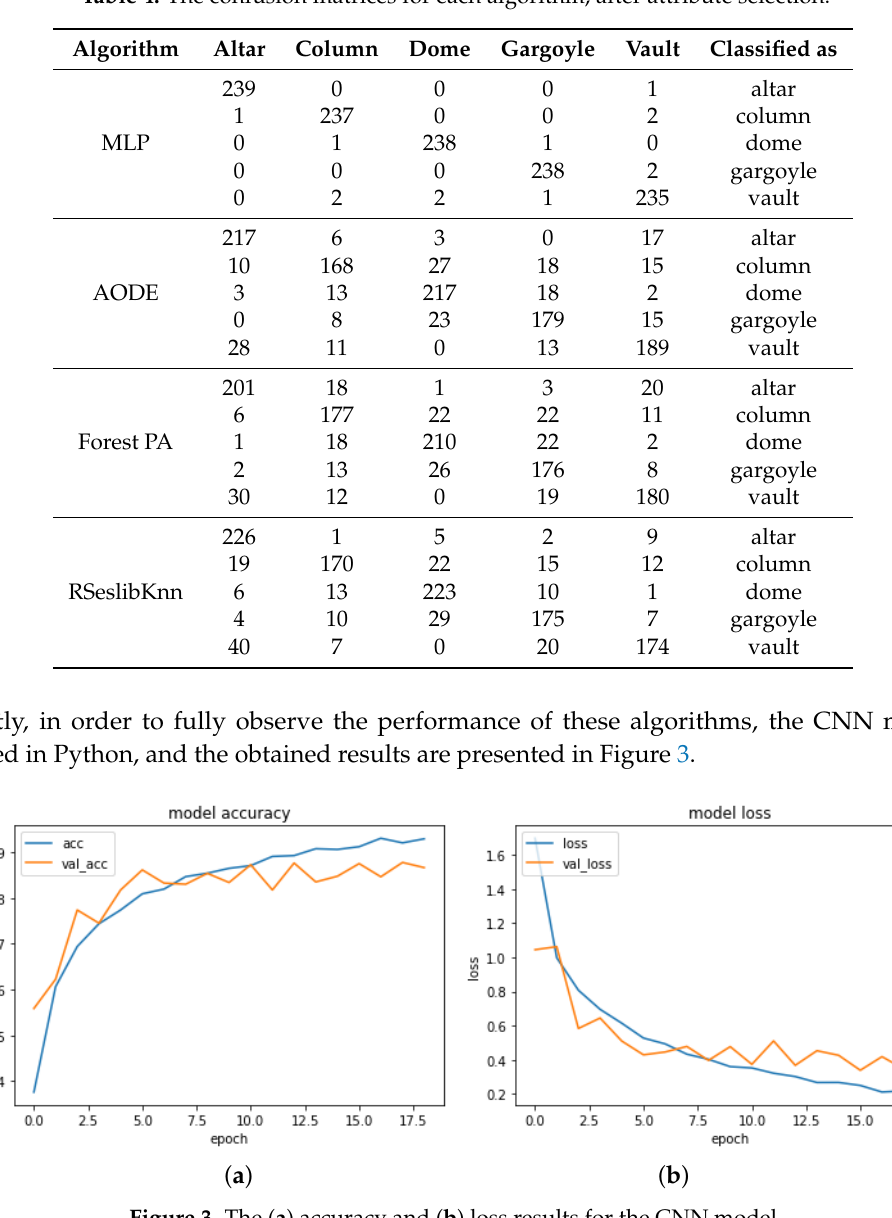
Table 4. The confusion matrices for each algorithm, after attribute selection.